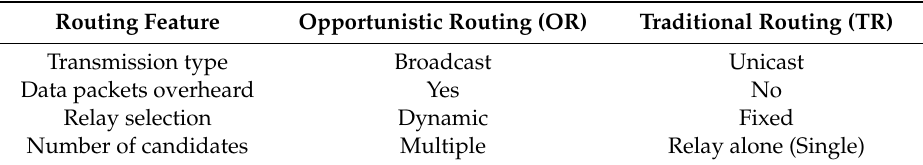
Table 1. Comparative study between opportunistic routing and traditional